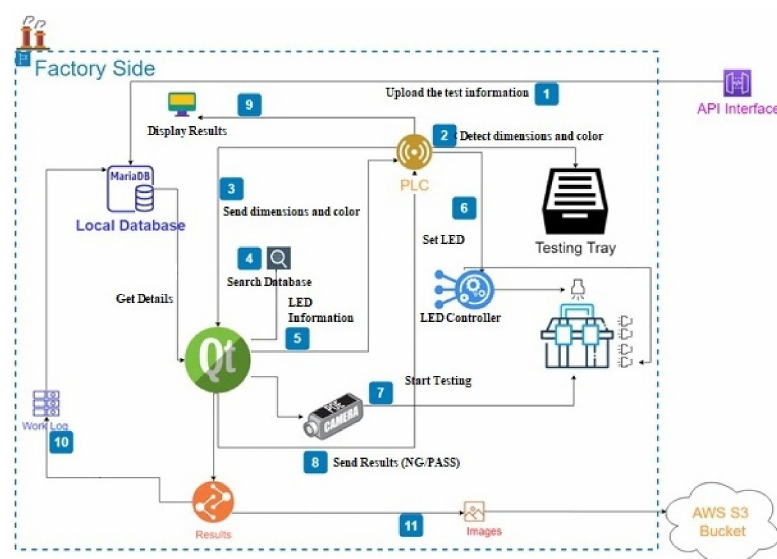
Figure 2. ALDB-DL Architecture for an Industrial